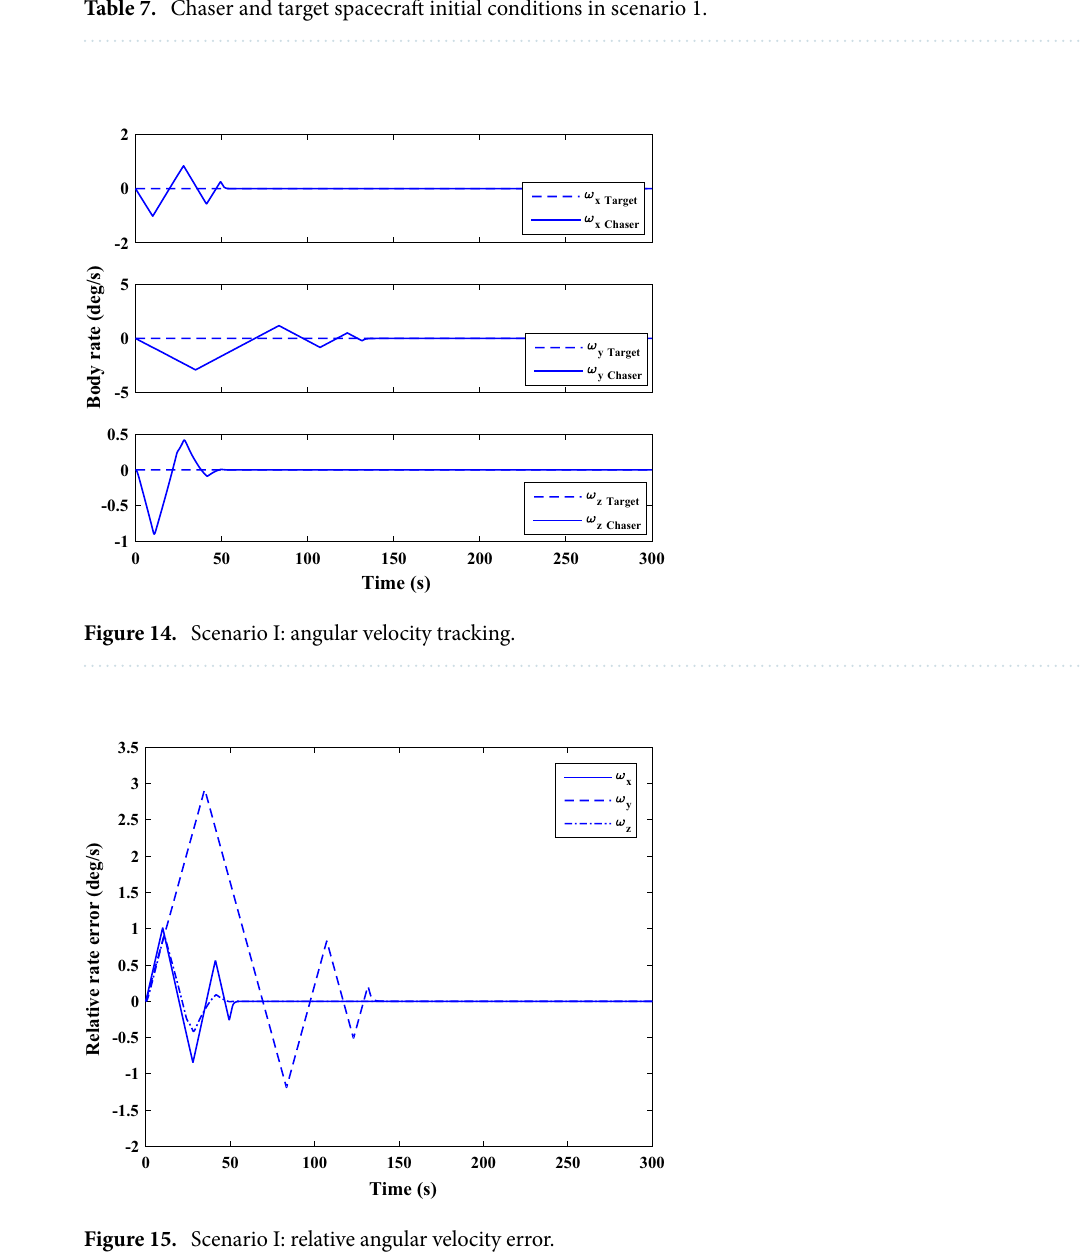
Table 7. Chaser and target spacecraft initial conditions in scenario 1.